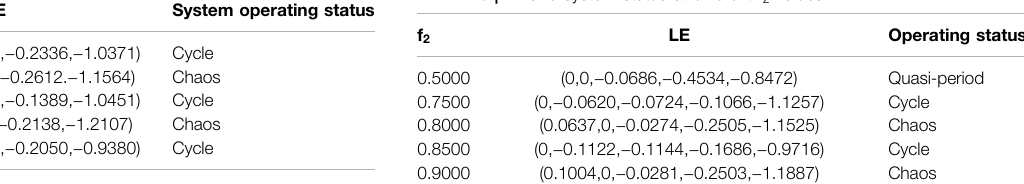
TABLE 5 | LE and system status at different f 2